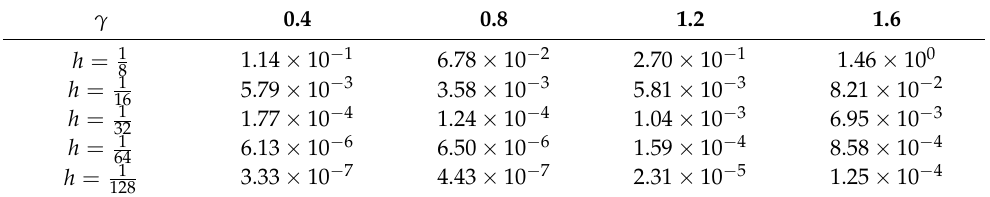
Table 4. Example 3: The infinity norm of the error (cid:107) e h (cid:107) for different values of γ and h when ω = 5 π